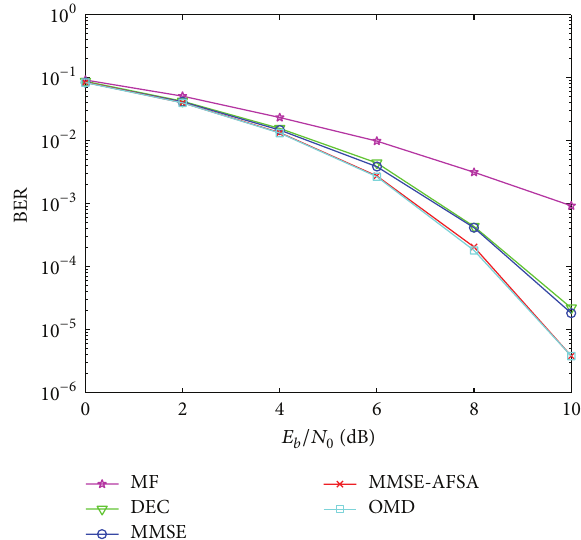
Figure 3: The BER performance versus 𝐸 𝑏 /𝑁 0 .